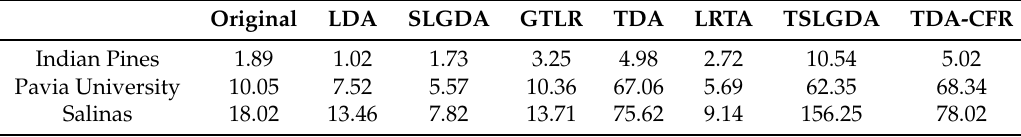
Table 4. The running time on three hyperspectral images (in seconds).